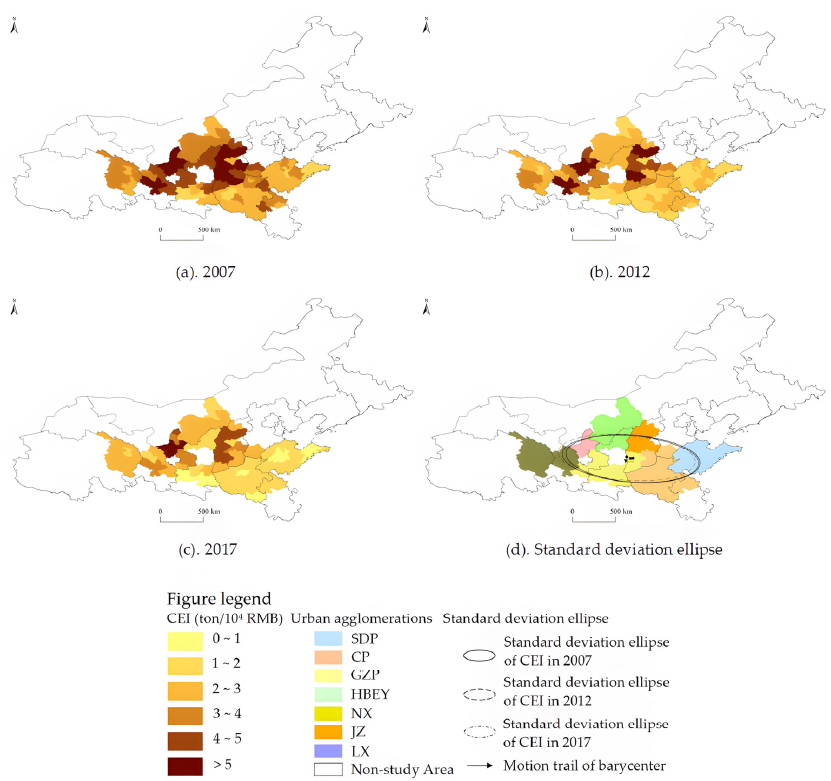
Figure 3. Spatial evolution characteristics of the CEI of cities in the YRB from 2007 to 2017.